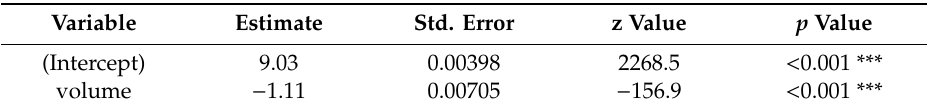
Table 6. Results of a GLM model describing the relationship between the number of Ips cembrae per trap tree and the volume of wood per trap (experiment 3). Corrected Akaike’s information criterion (AIC) = 312953. *** indicates significance at p < 0.001.